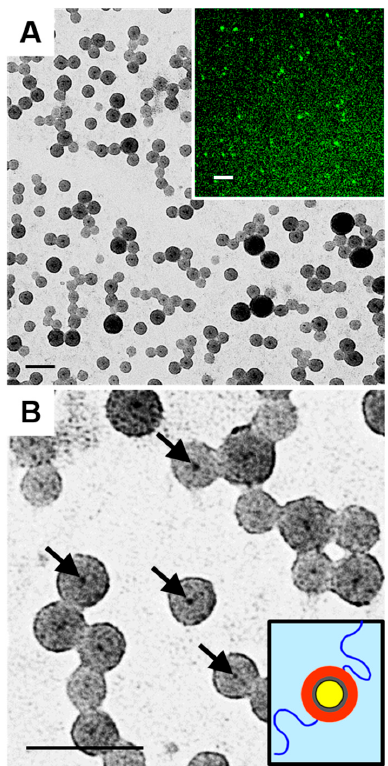
Figure 4. Core-shell QD-polymer nanoparticles formed from PS/PMAA-CdS in THF/water with c 0 = 0.75 wt % and R NaCl = 0 (no salt added). ( A ) Low-magnification TEM with LSCFM image (inset) showing QD emission. ( B ) High-magnification TEM with black arrows pointing to examples of QD cores with schematic of individual core-shell QD-polymer nanoparticle (inset). Scale bars are 100 nm, except in (A, inset) scale bar is 10 µm.